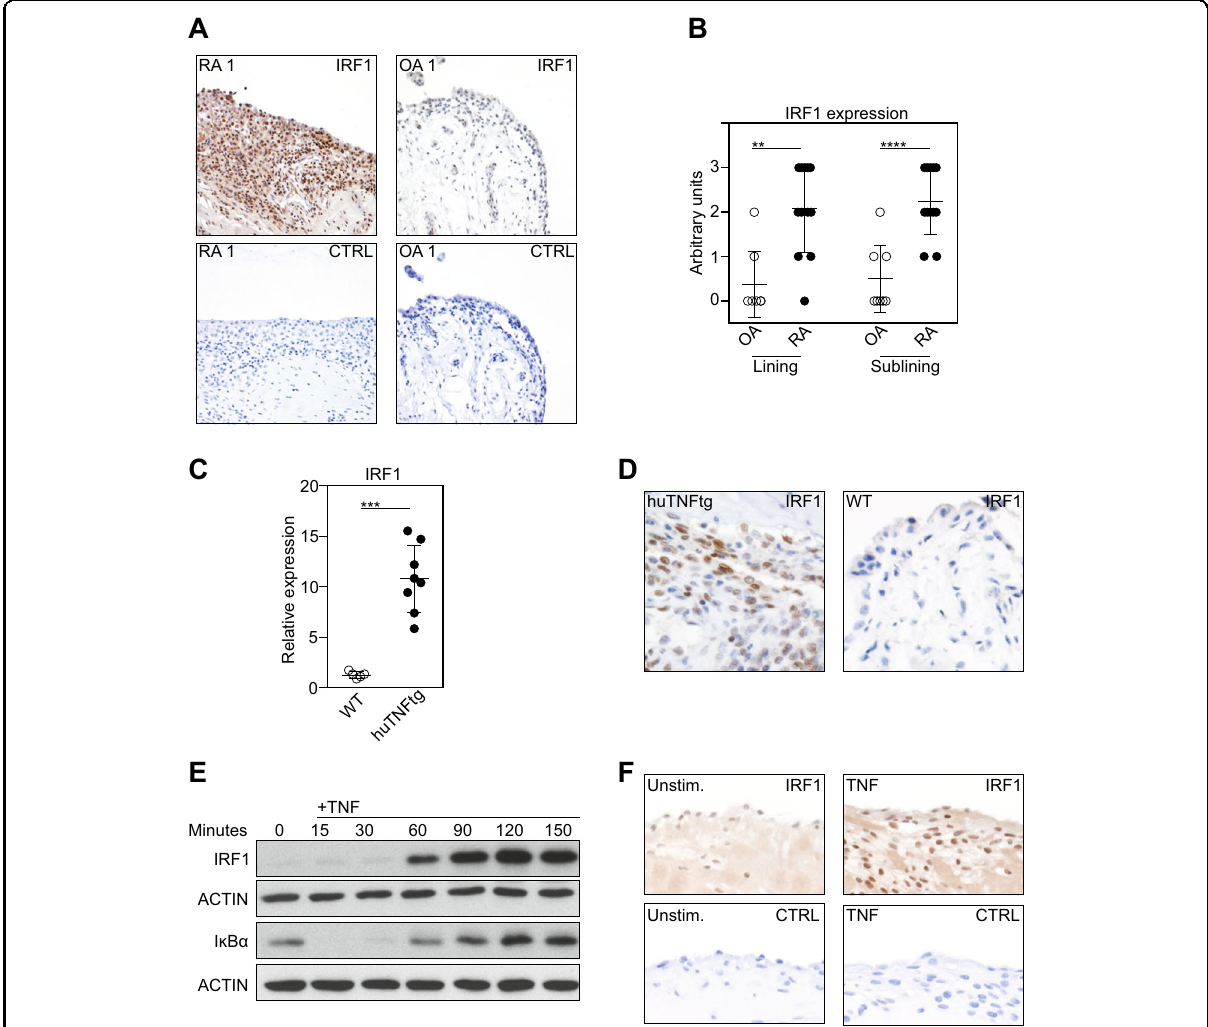
Fig. 1 TNF-induced IRF1 expression in RA-FLSs. a Representative immunostaining for IRF1 (brown staining) in rheumatoid arthritis (RA) and osteoarthritis (OA) synovial tissue samples (upper panel). Staining with an isotype-matched control antibody (CTRL) is presented in the lower panel. b Synovial tissue samples from 12 RA and 8 OA patients evaluated for IRF1 expression using a semiquantitative score (0 = no staining, 3 =